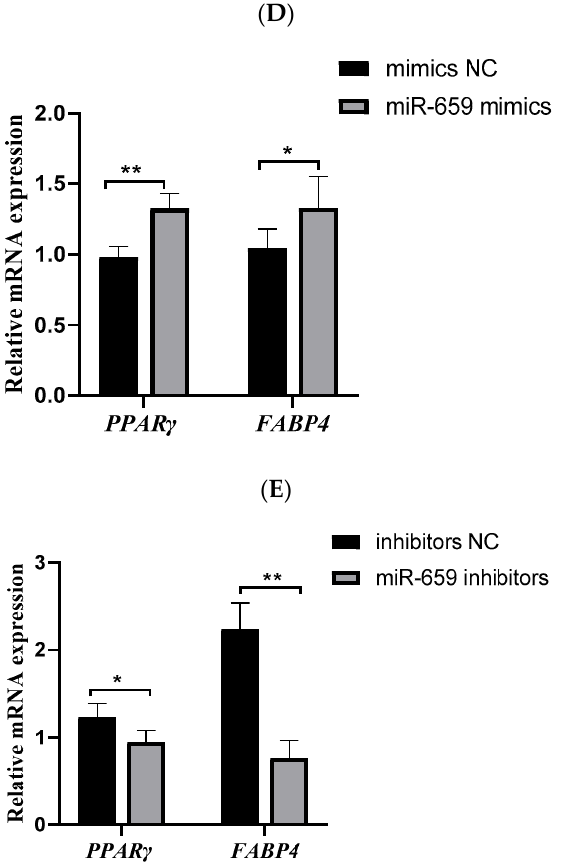
Figure 5. Novel-miR-659 promoted adipogenesis of pBMSCs by targeting SPP1 . ( A ) The interaction binding site of novel-miR-659 and SPP1 3 ′ UTR was predicted by TargetScan and miRDB. ( B ) Novel-miR-659 directly targeted the 3 ′ UTR of SPP1, normalized Renilla fluorescence activity forty eight hours following cotransfection of novel-miR-659 mimics and mimics NC with SPP1 -3 ′ UTR-WT and SPP1 -3 ′ UTR-MUT. ( C ) Adipogenesis of pBMSCs transfected with mimics/inhibitors NC or miR-659 mimics/inhibitors were stained by Oil Red O at 14 days after differentiation (bar = 200 μ m). ( D , E ) Expressions of PPAR γ and FABP4 in mimics NC, miR-659 mimics, inhibitors NC, and miR-659 inhibitors groups were detected by qPCR on day 14 after induction. **, p < 0.01; *, p < 0.05.